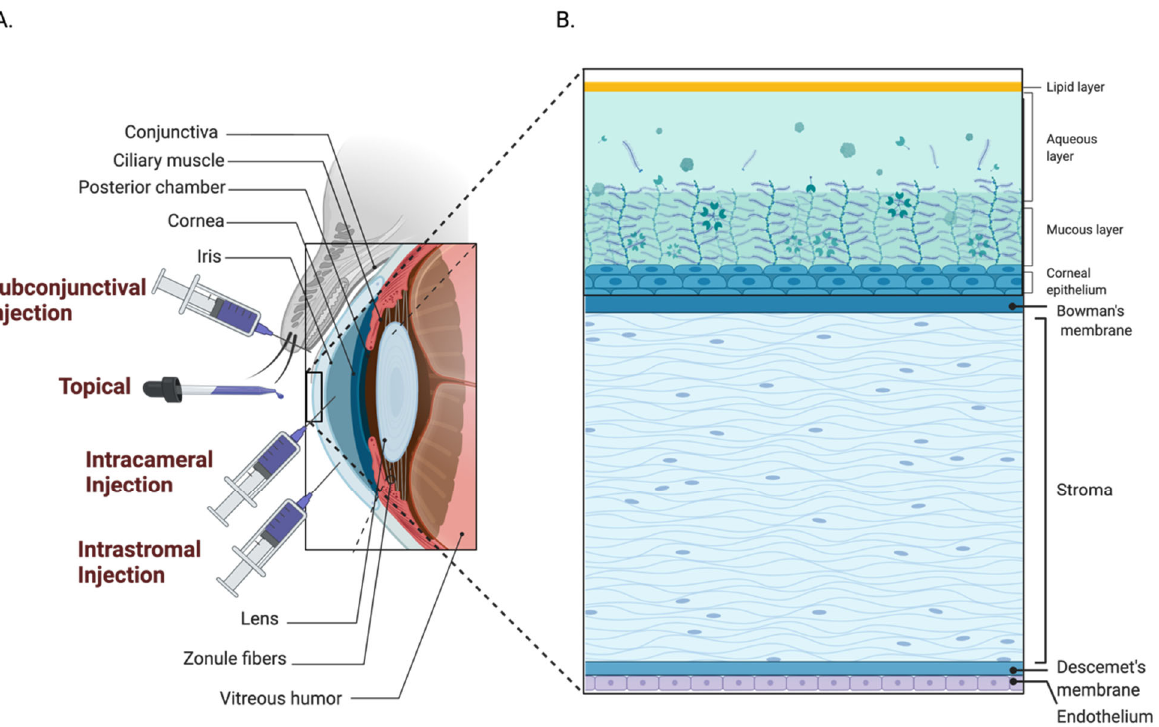
Figure 5. Drug administration routes to the anterior segment of the eye. ( A ) Subconjunctival injections are a type of periocular route of administration where the drug is injected under the conjunctiva (epibulbar) or underneath the conjunctiva lining the eyelid (subpalpebral). Intracameral injection delivers medication directly to the anterior chamber/aqueous humor of the eye. Topical administration is most used in drop form and delivers the solution to the exterior of the eye. Intrastromal injection administers the drug directly to the thick, fibrous stroma of the cornea. ( B ) Figure 3B depicts the layers of the tear film and cornea. The tear film stretches from the lipid layer to the mucous layer and the cornea from the corneal epithelium to the endothelium.